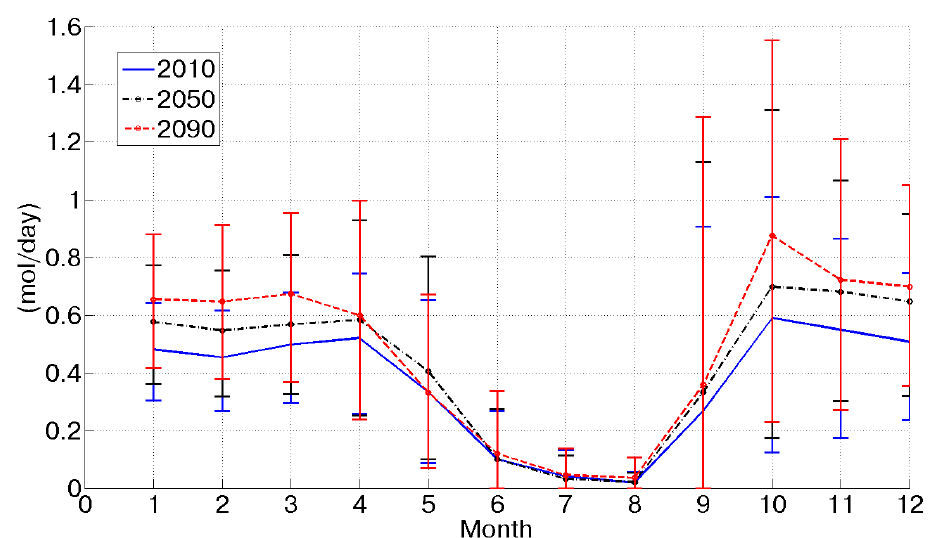
Figure 6. Mean daily actual assimilation for each month limited by soil moisture availability in the three considered scenarios.